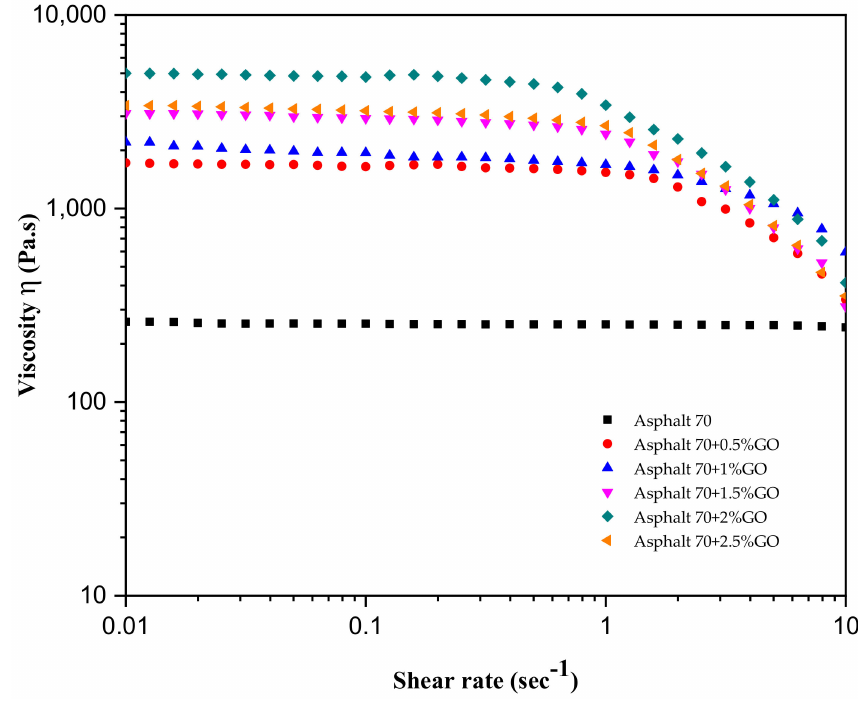
Figure 3. Viscosity versus shear rate at 60 ◦ C for different GO-modified